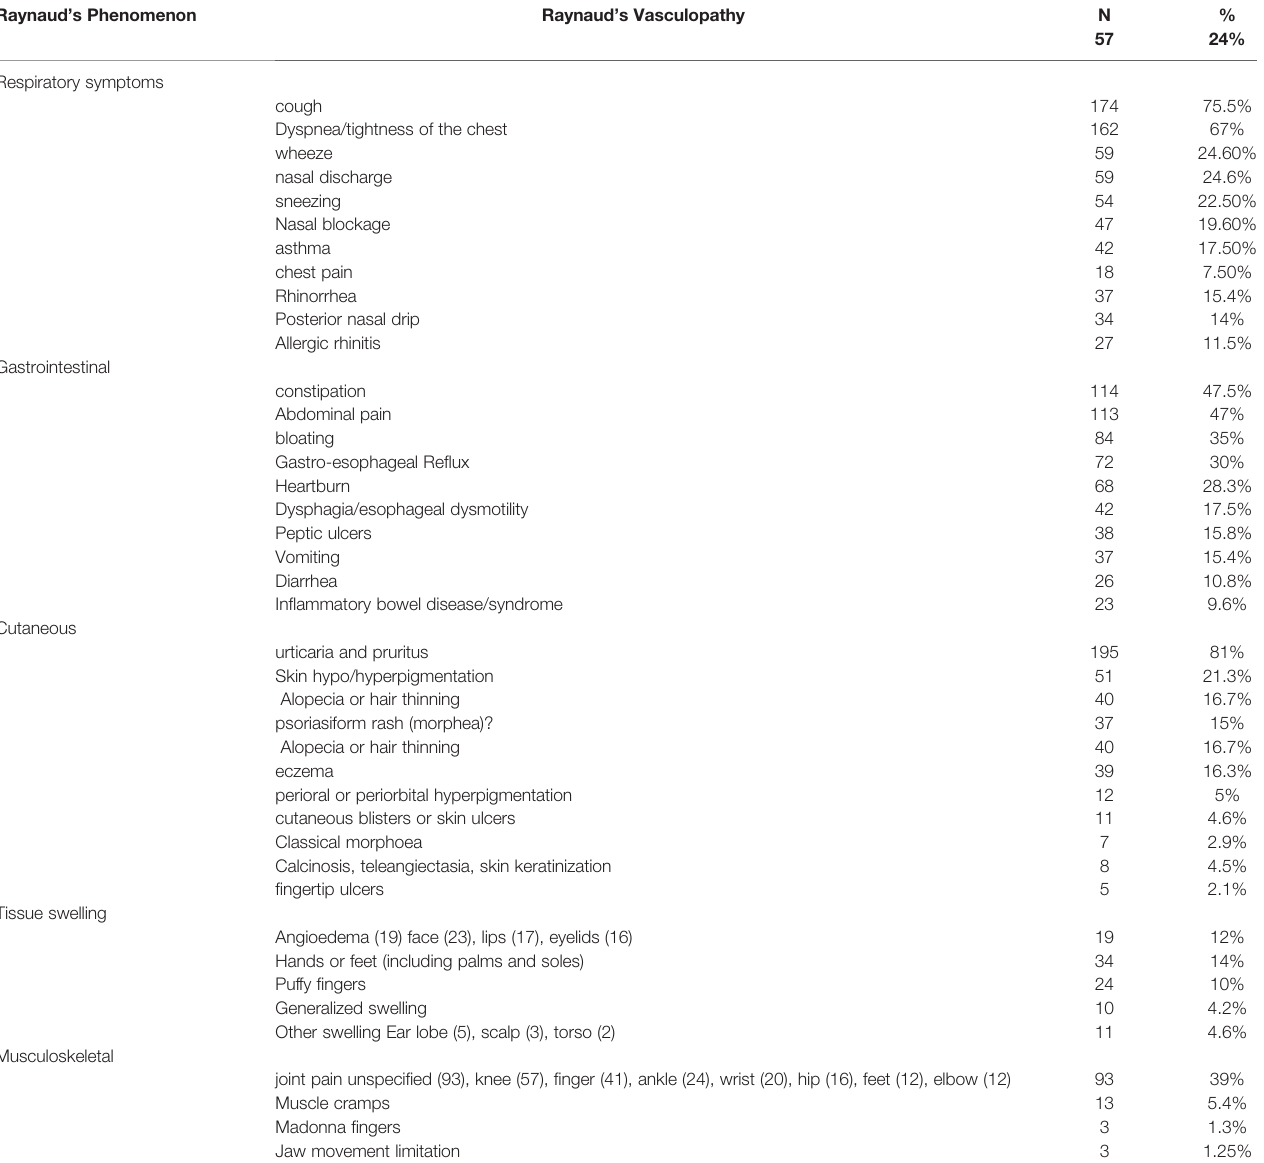
TABLE 4 | Frequency and types of vascular, respiratory, gastrointestinal, cutaneous and musculoskeletal symptoms reported by patients with SSc-speci fi c autoantibodies. Raynaud ’ s Phenomenon Raynaud ’ s